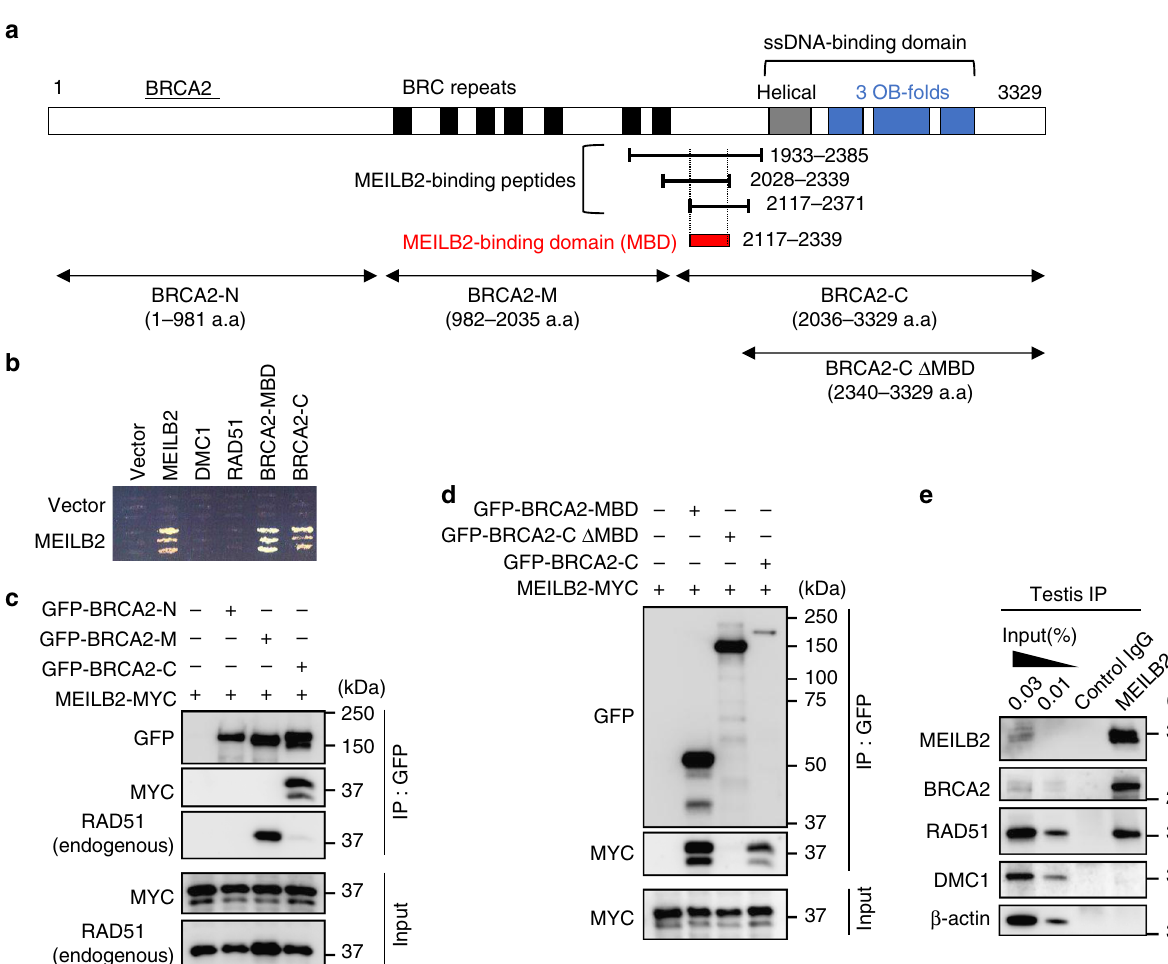
Fig. 2 Identi fi cation of BRCA2 as a MEILB2-binding protein. a The domain conformation of BRCA2. The BRC repeat domains, helical domain, and OB-fold domains are shown. Three unique peptides (a.a. 1933 – 2385, 2028 – 2339, and 2117 – 2371) identi fi ed in the yeast two-hybrid screening as MEILB2-binding peptides are shown. The common domain (a.a. 2117 – 2339) in all three peptides is also shown as the MEILB2-binding domain (MBD). b Yeast two-hybrid interactions between MEILB2 (prey) and MEILB2, DMC1, RAD51, BRCA2-MBD, and BRCA2-C (bait). c , d Immunoprecipitates with the green fl uorescent protein (GFP) antibody from B16-F1 cells expressing MEILB2-MYC and GFP-BRCA2 truncations N (a.a. 1 – 981), M (a.a. 982 – 2035), or C (a.a. 2036 – 3329) in c and MBD (a.a. 2117 – 2339), C Δ MBD (a.a. 2340 – 3329), or C (a.a. 2036 – 3329) in d . Input and immunoprecipitates (IP) were immunoblotted with the indicated antibodies. e IP from mouse testis extracts with the MEILB2 antibody or with IgG as the negative control and immunoblotted with the indicated antibodies. The blots with β -actin served as the loading